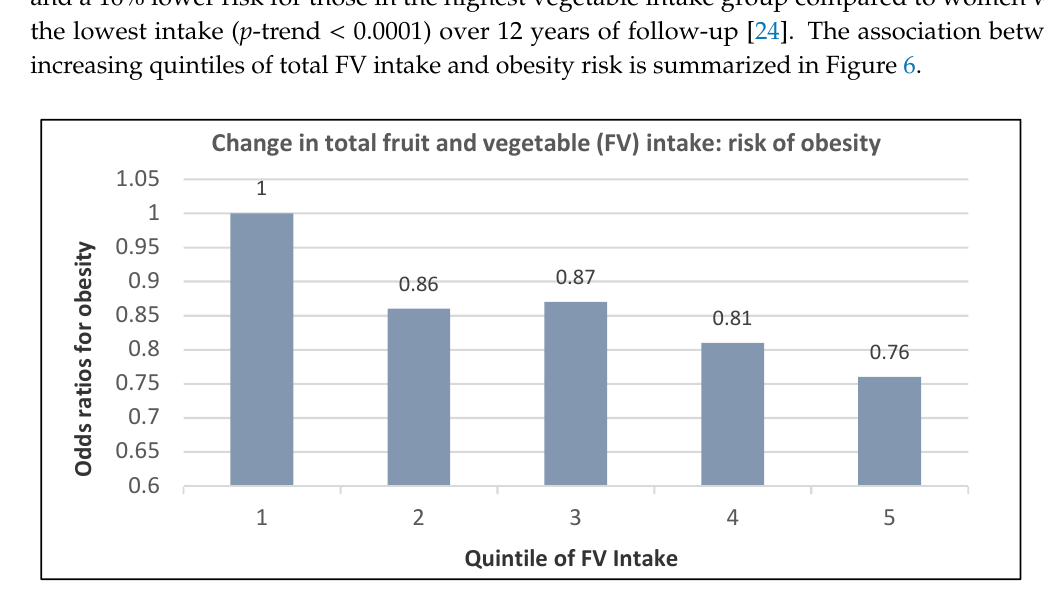
Figure 6. Multivariate adjusted evaluation of total fruit and vegetable intake and risk for obesity over 12 years in women from the Nurses’ Health Study (mean baseline age 50 years and BMI 24.9 ( p -trend <0.0001; median change in quintile fruit and vegetable servings from baseline −2.36, −0.49, 0.64, 1.83, and 3.99) [24].